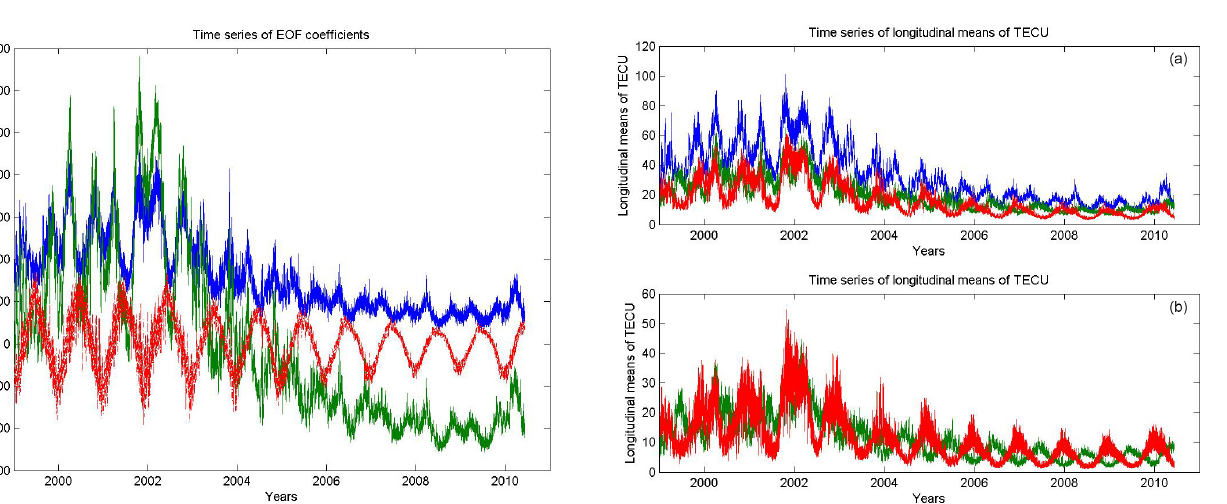
Figure 15. Two-hour resolution time series of the longitudinally averaged TEC at five different latitudes: 0 ◦ , 40 ◦ S, 40 ◦ N – blue, green, red lines in panel (a) ; 60 ◦ S, 60 ◦ N – green, red lines in panel (b)